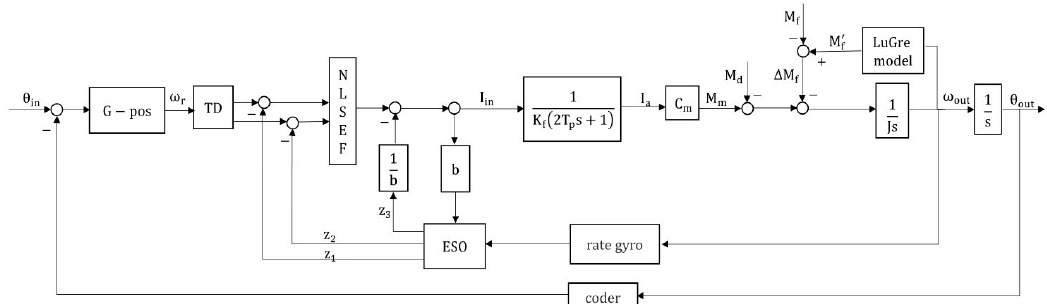
Figure 6. Block diagram of the ADRC structure with LuGre friction